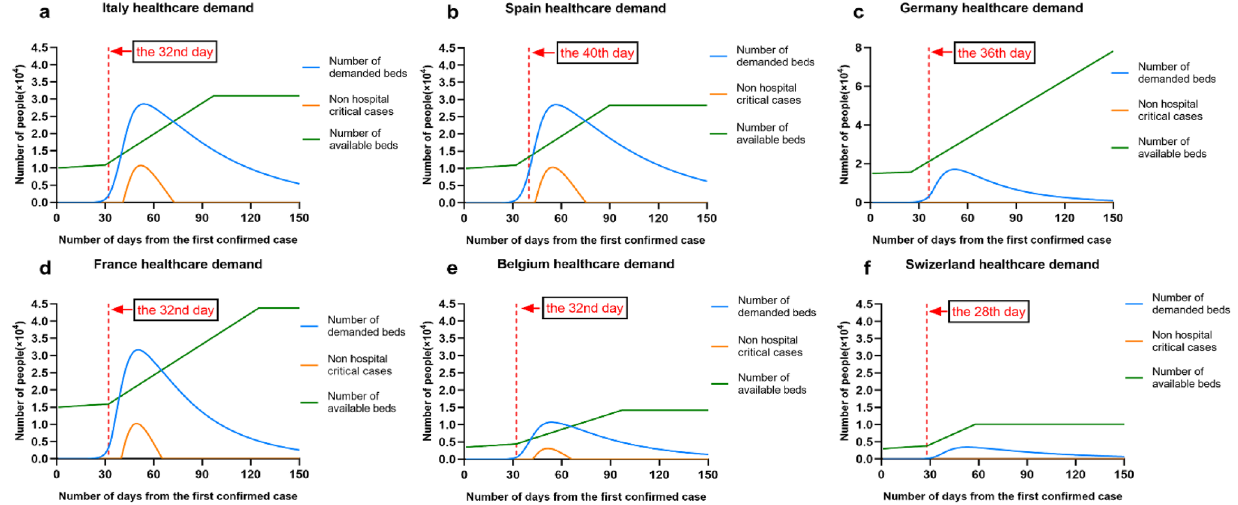
Figure 5. Illustration healthcare demand in 6 European countries (Italy, Spain, Germany, France, Belgium and Switzerland) by implementing suppression